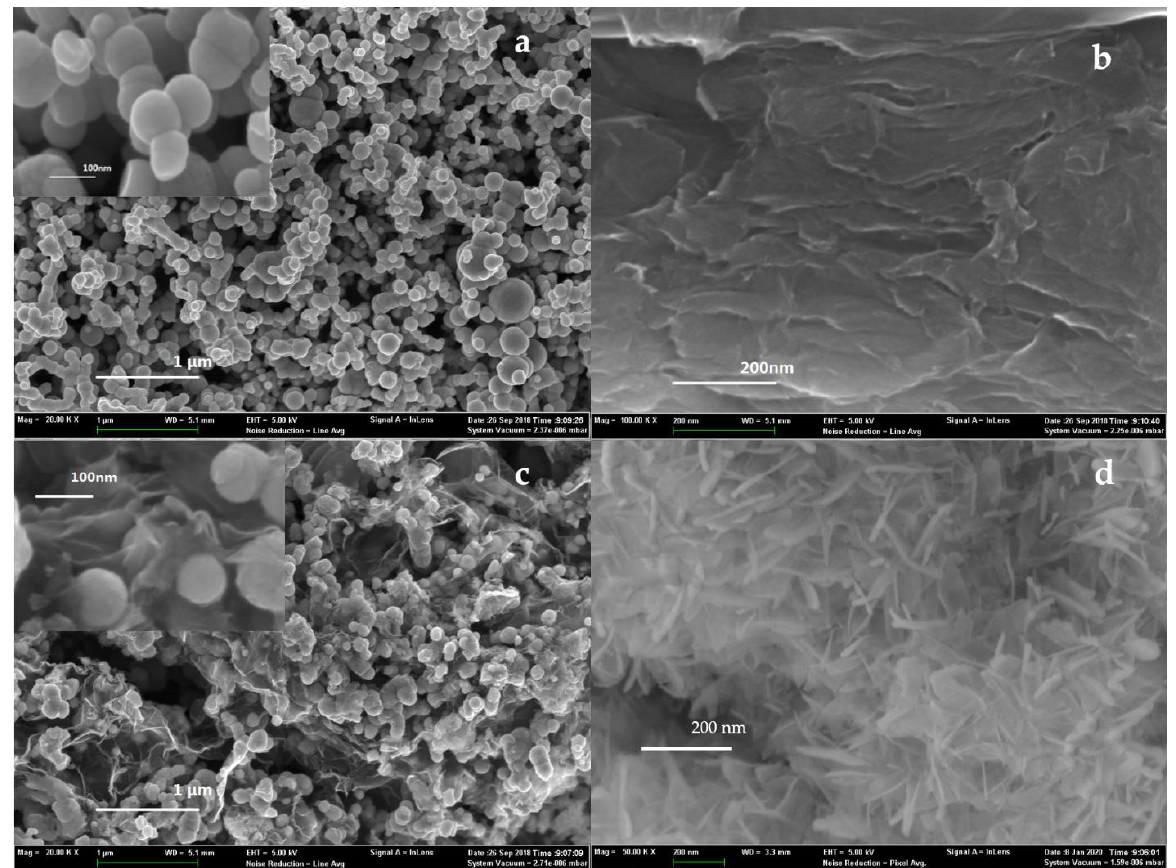
Figure 4. SEM images of ( a ) nZVI, ( b ) GO, ( c ) nZVI/rGO, and ( d ) solids obtained after reaction.